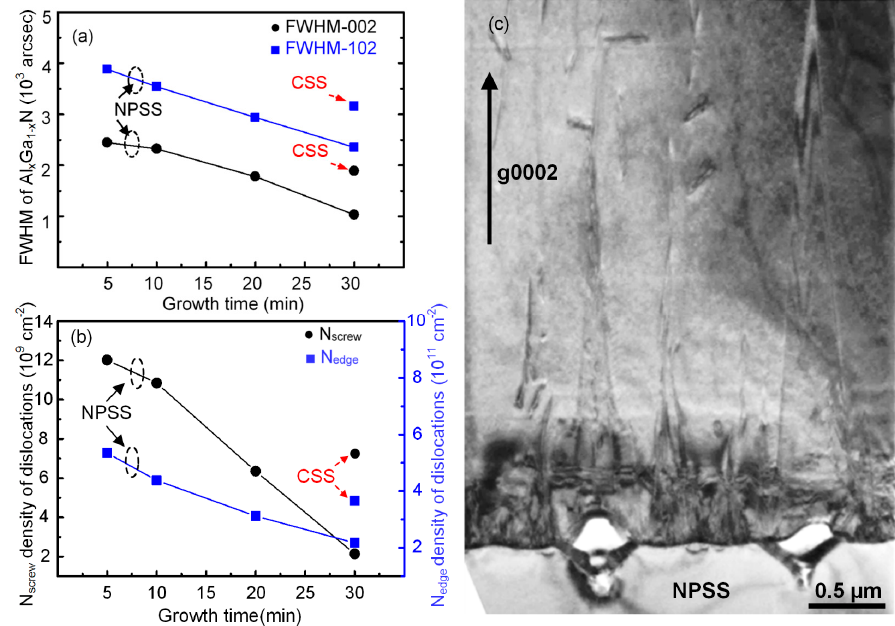
Figure 7. ( a ) Double-crystal x-ray diffraction (DCXRD) full-widths at half-maximum (FWHMs) of (0002)- and (10-12)-AlGaN on NPSSs for various growth times (5, 10, 20, and 30 min); ( b ) Calculated screw and edge dislocation densities of AlGaN samples on NPSSs for various growth times. The data for HVPE AlGaN sample grown on a CSS for 30 min are also depicted for comparison; ( c ) Bright field TEM image of 3- µ m-thick AlGaN epilayer grown on an NPSS with g = 0002. The corresponding threading dislocation densities in various depths are also measured.